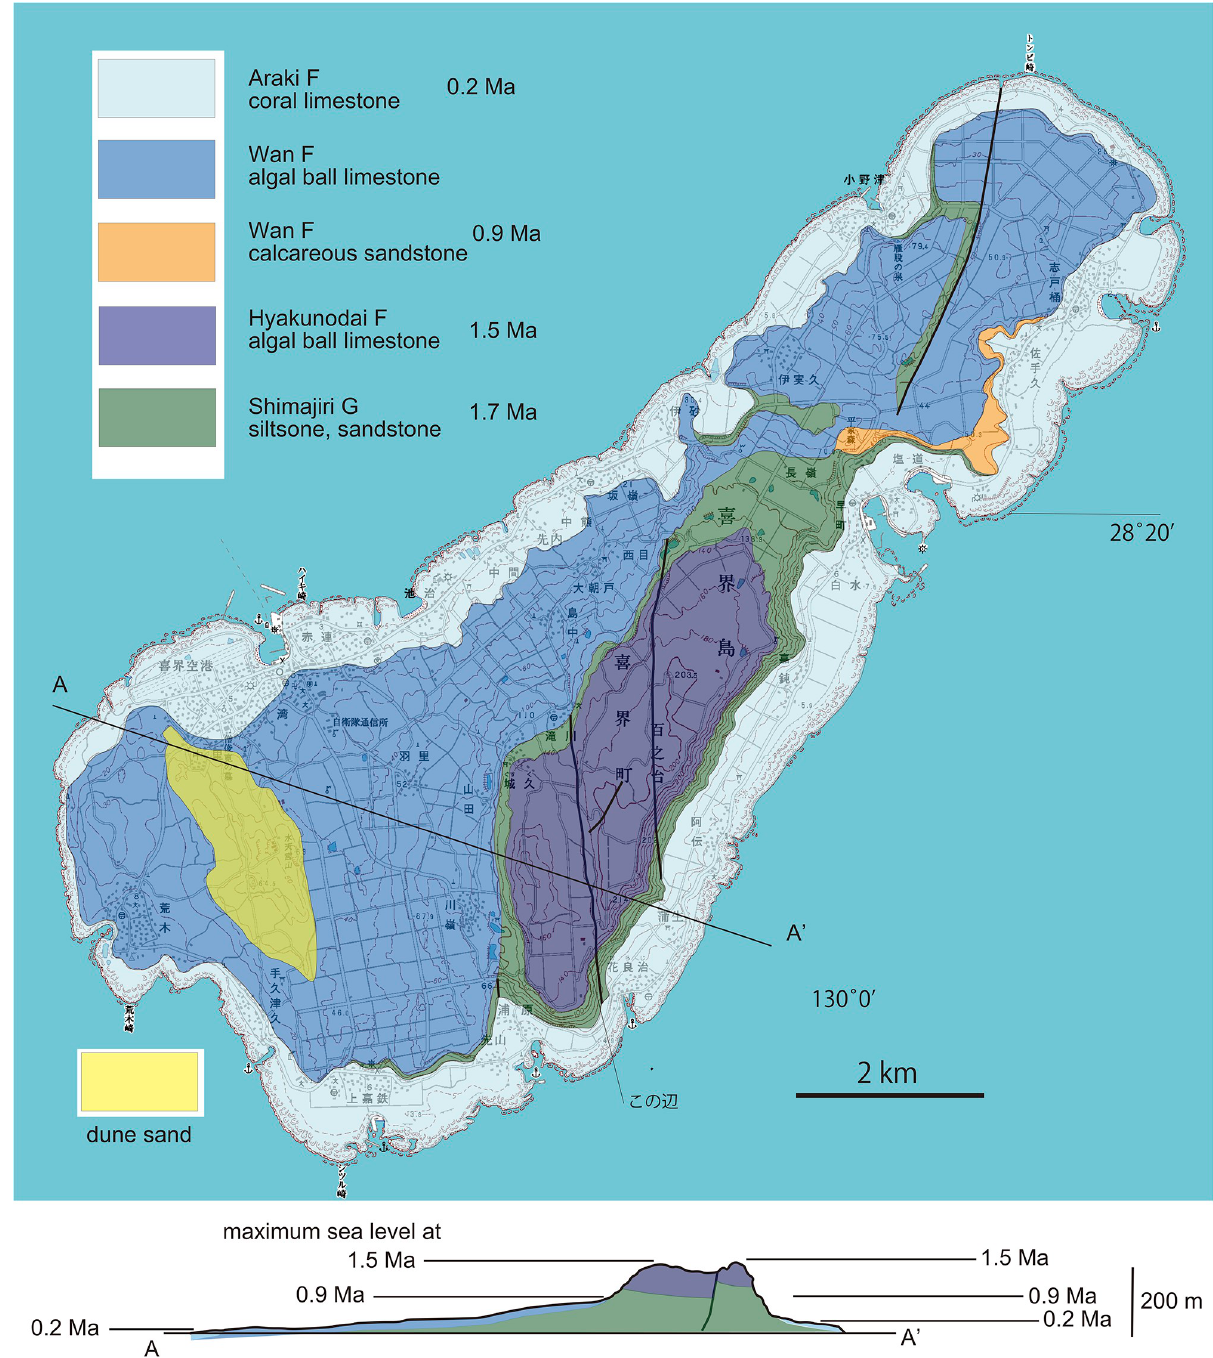
Fig 16. Geological map and cross section (below) of Kikai-jima island. Three terraces of the 1.5, 0.9 and 0.2 Ma limestone show three episodes of uplift or progressive uplift with erosion of wavecut benches during high sea level stands. Note the lack of a coastal plain at 0.9 Ma (100 m high sea cliff), but a relatively wide coastal plain at 0.2 Ma above a lower sea cliff. Background: Digital topographic maps of 1: 25,000 scale, the Geospatial Information Authority of Japan.